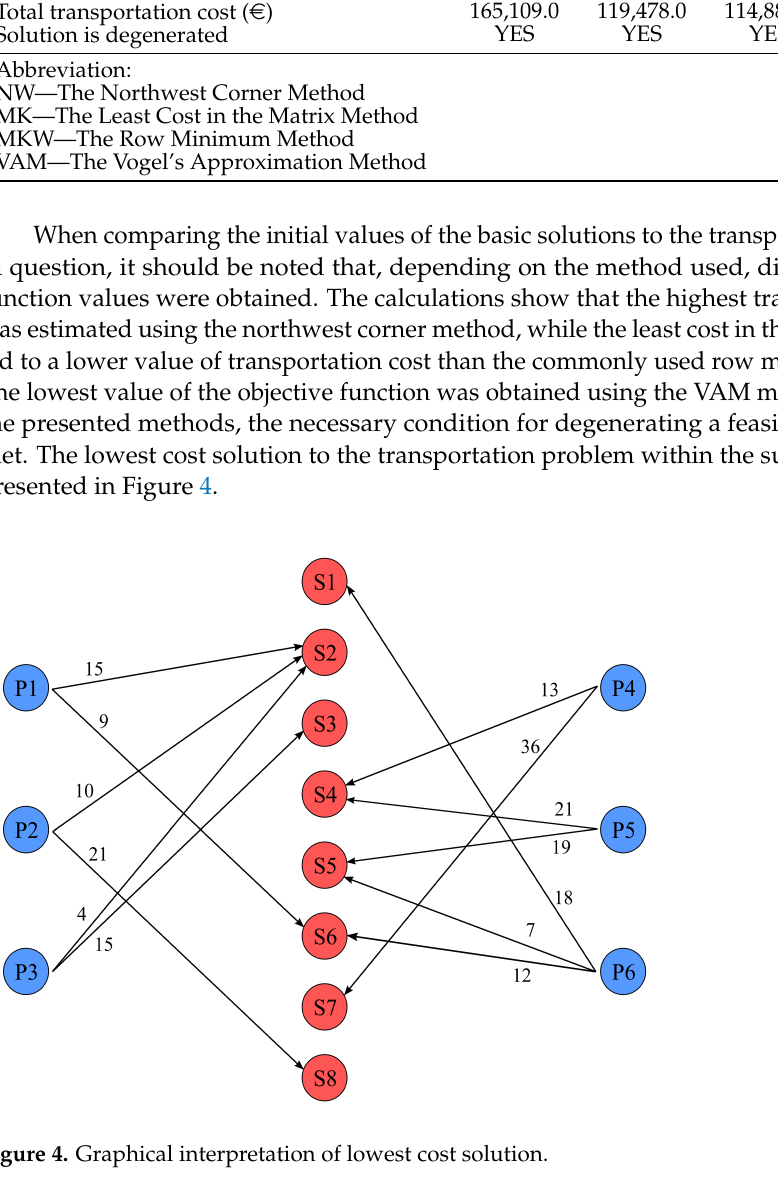
Figure 4. Graphical interpretation of lowest cost solution.